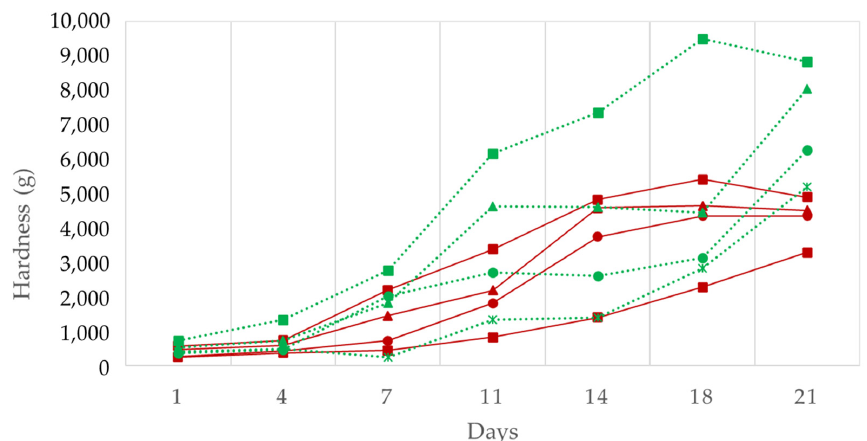
Figure 5. The effect of replacing pork backfat with high oleic sunflower oil on hardness in the traditional and reduced fat “Chorizo Zamorano” formulations during ripening. Traditional: ( ■ ) Control, ( ▲ ) 12.5%, ( ● ) 20%, and (×) 50% of backfat replacement. Reduced fat: ( ■ ) Control, ( ▲ ) 12.5%, ( ● ) 20%, and (×) 50% of backfat replacement.